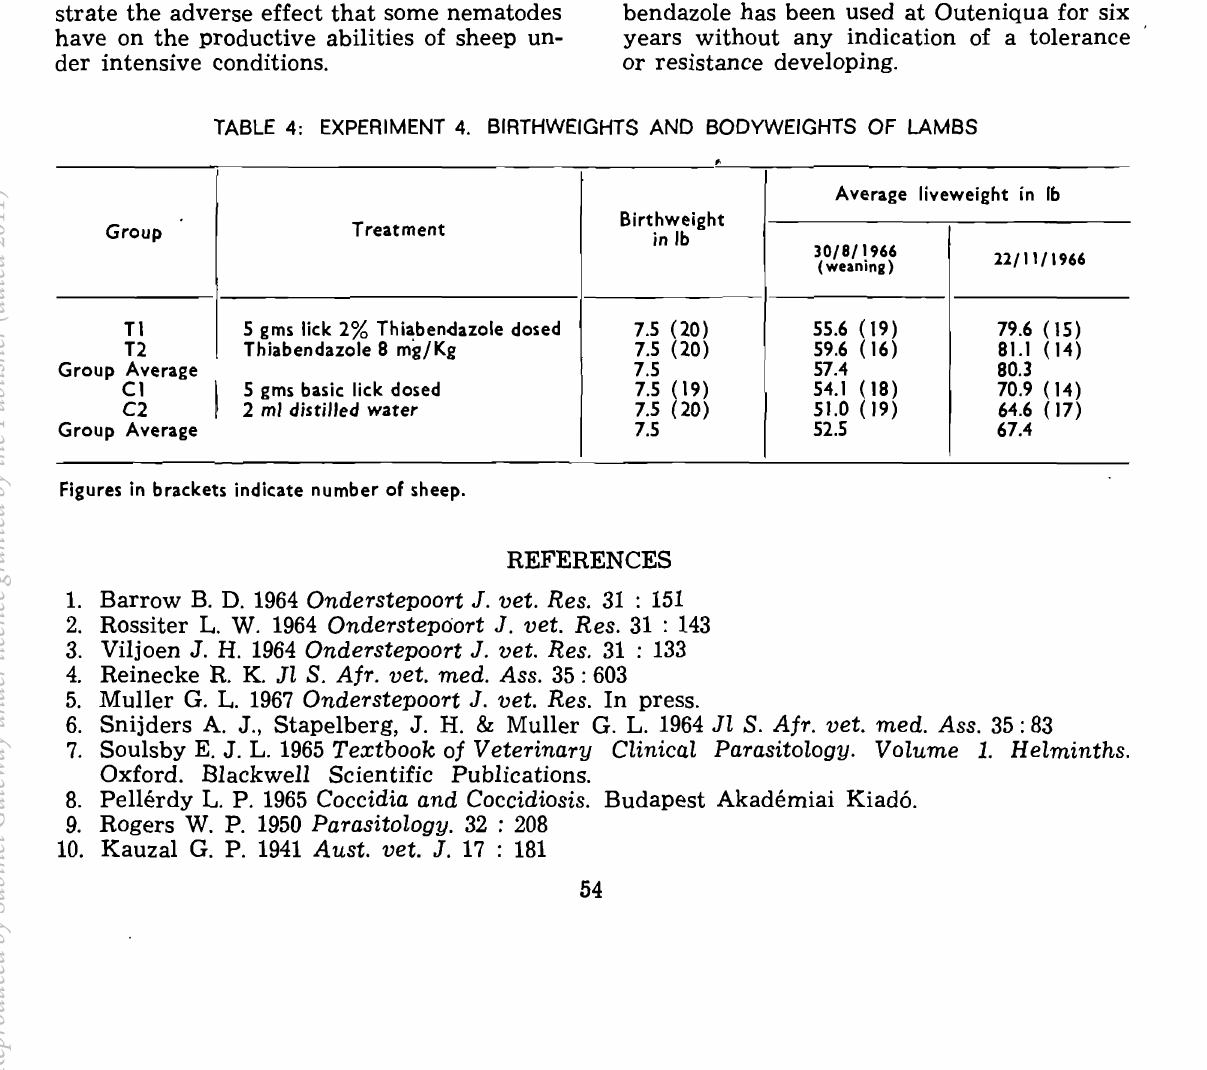
TABLE 4: EXPERIMENT 4. BIRTHWEIGHTS AND BODYWEIGHTS OF LAMBS